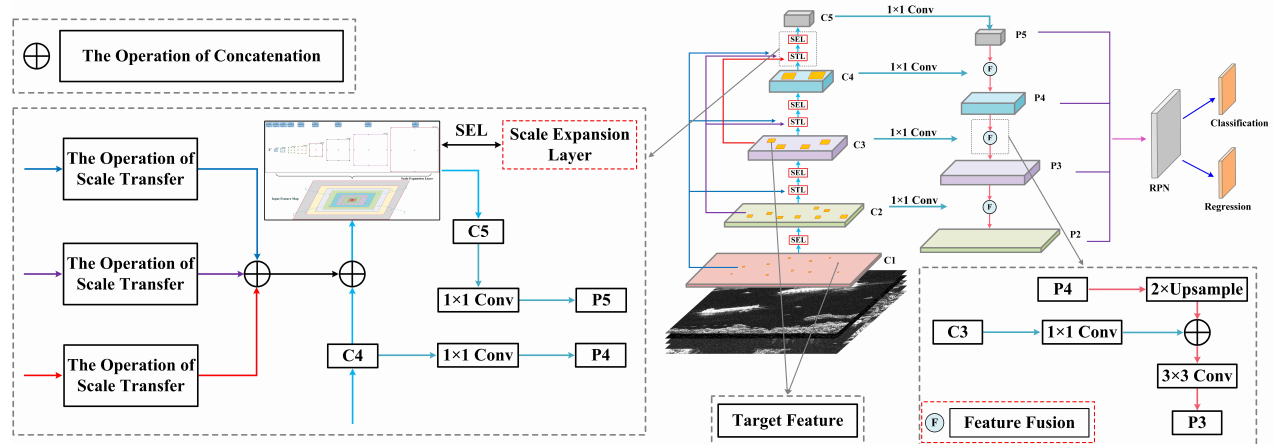
Figure 7. Architecture of UltraHi-PrNet. When the scale transfer layer and scale expansion layer are placed in the network layer, the whole network can realize the extraction of various scale difference